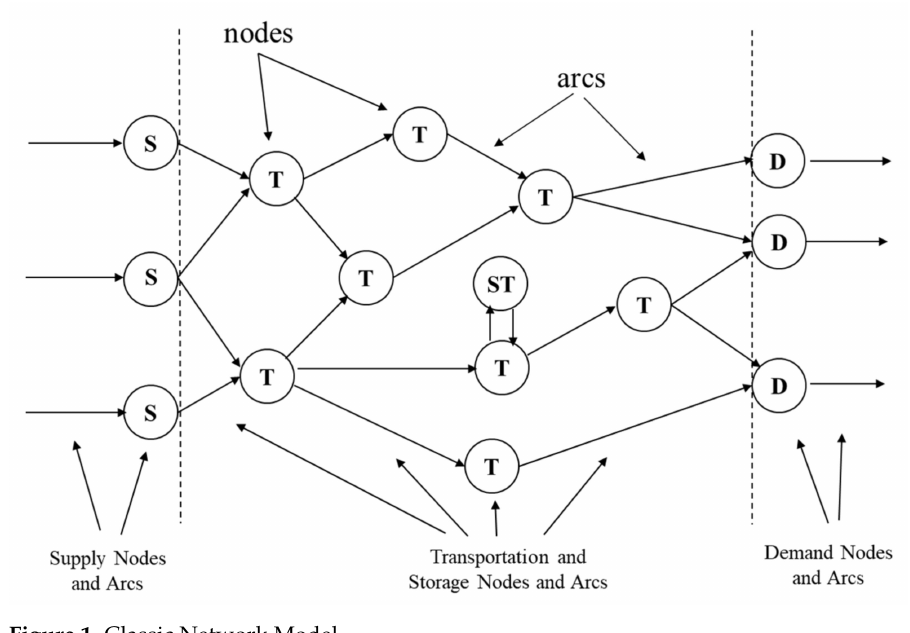
Figure 1. Classic Network Model.